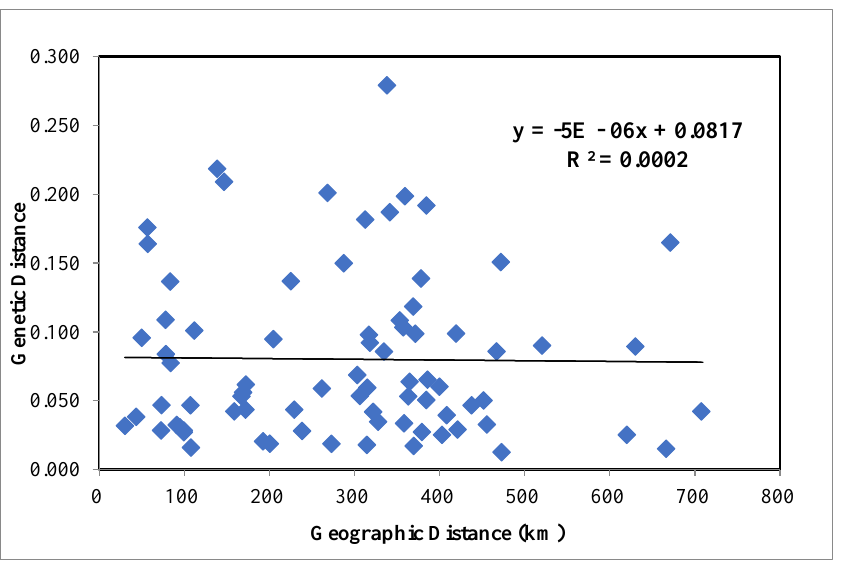
Figure 2. Mantel test between genetic distance and geographical distance of 13 P. orientalis popu- la Table 3. 3. Population Clustering and Genetic Structure of P. orientalis.